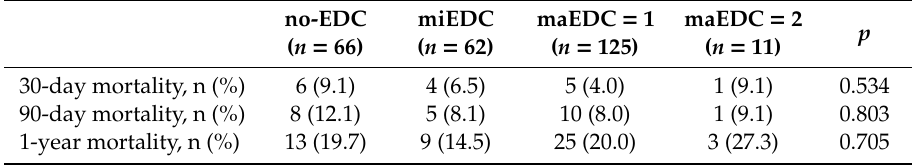
Table 3. Patient mortality following liver transplantation in patients with HCC.